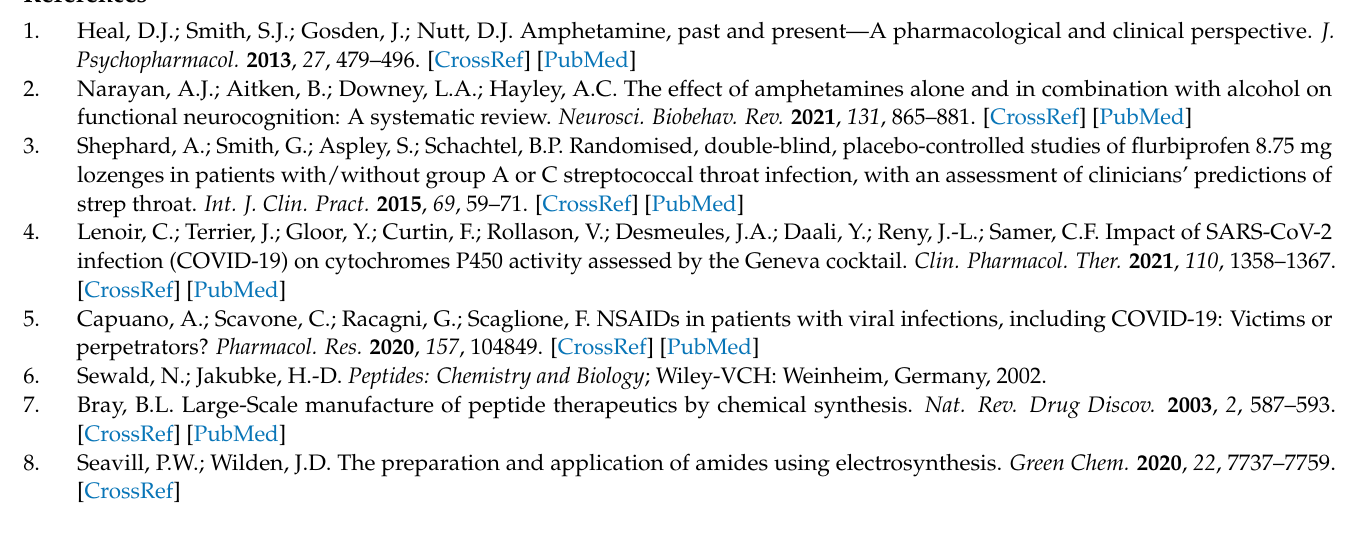
H-NMR spectrum of compound 3 ; Figure S1a: Part of 1 H-NMR spectrum of compound 3 ; Figure S1b: Part of 1 H-NMR spectrum of compound 3 ; Figure S2: 13 C-NMR spectrum of compound 3 ; Figure S3: UV spectrum of compound 3 ; Figure S4: ESI-HRMS of compound 3 ; Figure S5: IR spectrum of compound 3 ; Figure S6: HPLC chromatogram of compound 3